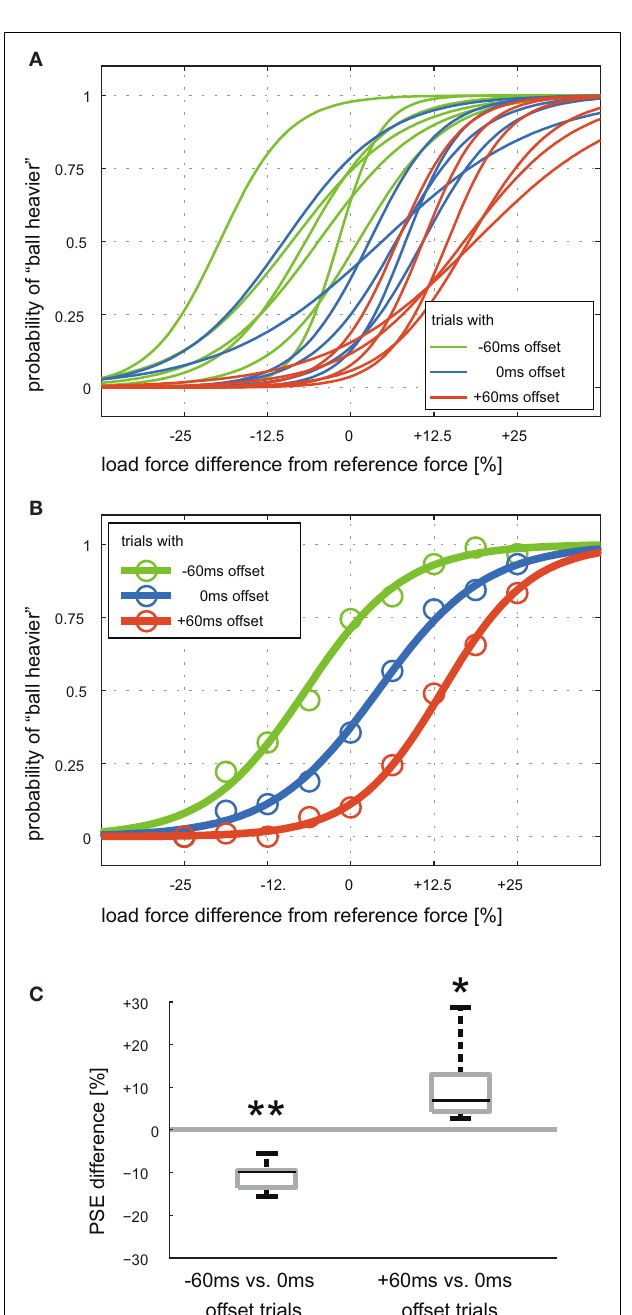
FIGURE 6 | Psychometric curves for weight judgment after “sync” conditioning. (A) Psychometric curves for each participant. Green, blue, and red colors represents − 60, 0, and + 60ms time offsets in weight judgment trials. Offset values are positive in the case where force was applied after visual contact.The horizontal axis represents percent difference in load force magnitude from the reference force. (B) Group-average psychometric curves. Circles represent group-average of the probability of judging that the load force was heavier than the reference force. (C) Box plots of the difference in point of subjective equality (PSE). The left box represents the difference in PSEs for 0 and − 60ms offset trials. The right box represents the difference in PSEs for 0 and + 60ms offset trials.The whiskers correspond to minimum and maximum values. Asterisks denote that the difference in PSE is significantly greater or less than zero: * P < 0.05, ** P < 0.01.